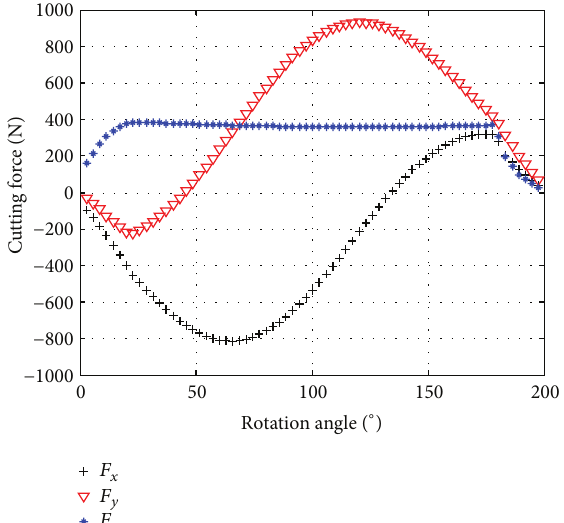
Figure 18: Simulated cutting forces in end